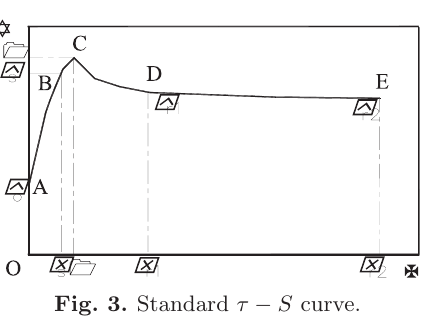
Fig. 3. Standard τ − S